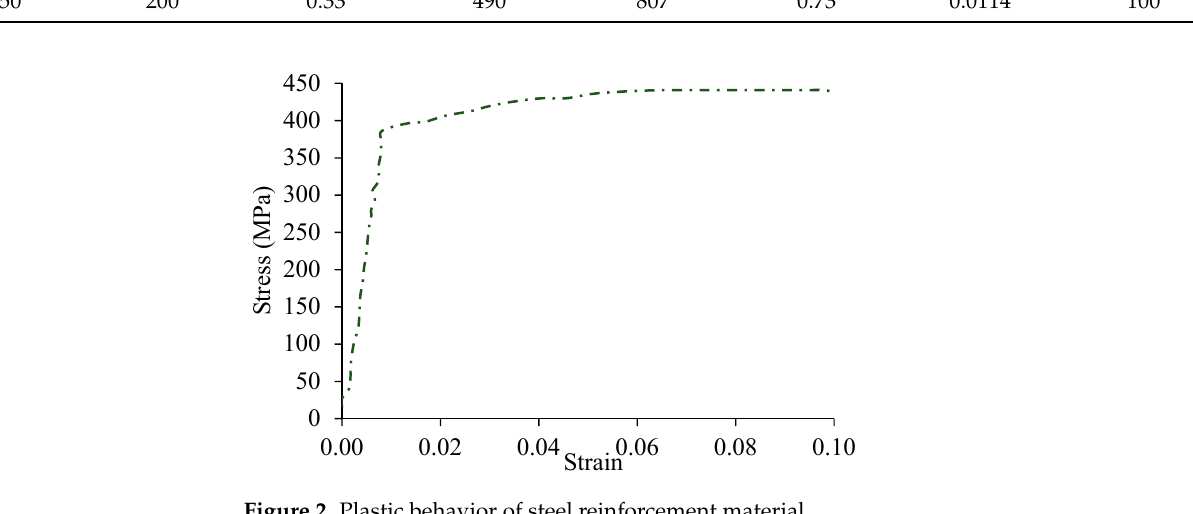
4 of 14 Figure 1. Geometry of finite element model for impact loading simulation . ( a ) Abaqus model of Missile, 0.7637 m in length and a mass of 100 kg with 5 Mach velocity ( b ) Tunnel with an opening of 7 m in diameter and supported by a reinforced concrete(M30) liner of 0.35 m in thickness. ( c ) The rock surrounding the tunnels of 50 m × 50 m × 50 m and 12.5 m of overburden depth.